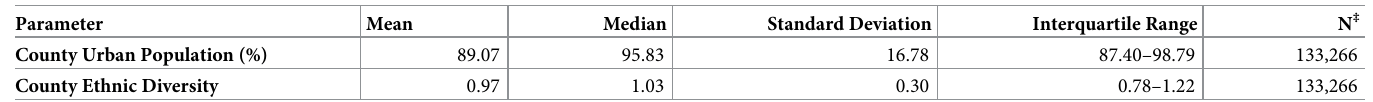
Table 4. Descriptive statistics depicting county-level continuous variables